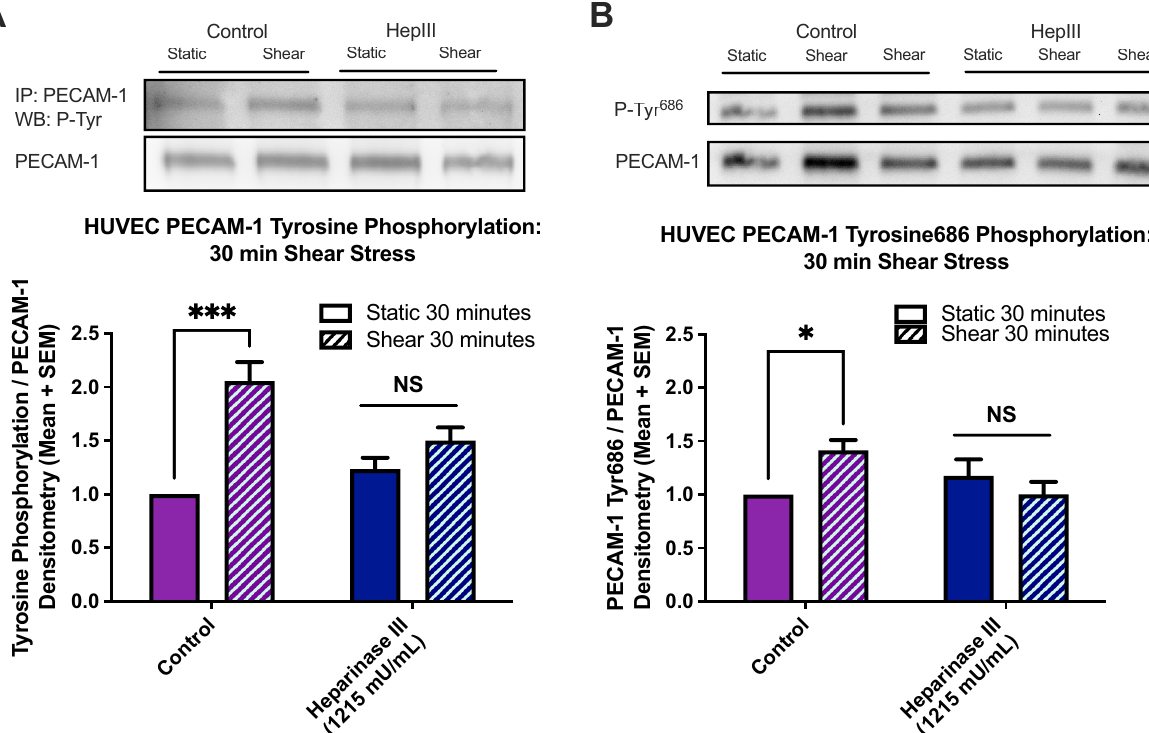
Figure 6. HS cleavage blocks shear-induced PECAM-1 tyrosine kinase phosphorylation at 30 min in HUVEC. Heparinase III (1215 mU/mL) was used to cleave HS from HUVEC monolayers 2 h prior to fluid shear stress exposure. ( A ) PECAM-1 phosphorylation levels were measured using western blotting for total tyrosine phosphorylation (following PECAM-1 immunoprecipitation) and ( B ) for PECAM-1 specific tyrosine 686 phosphorylation. Full length blots are presented in Supplemental Figure S8. Densitometry values from both phosphorylation types were normalized to PECAM-1 expression in each sample and then normalized to untreated static control levels within each set. From left to right within each set, ( A ) n = 6, 13, 5, 14 for total tyrosine phosphorylation ( B ) n = 6, 12, 6, 12 for tyrosine 686 phosphorylation. Results in each graph are averaged from 5 or more independent experiments. *P < 0.05 using one-way ANOVA followed by Sidak’s multiple comparisons